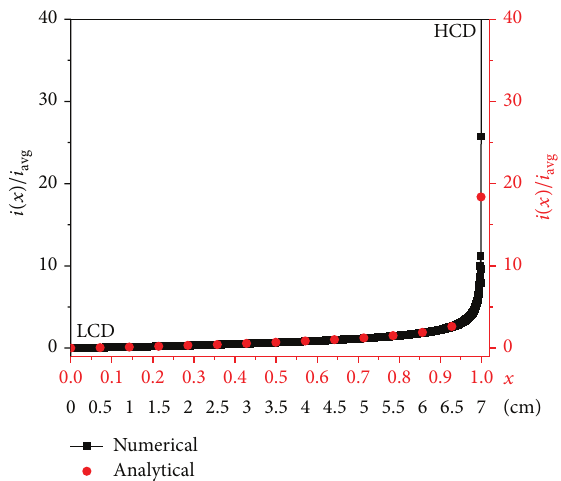
Figure 8: Comparison of analytical and numerical solutions for primary current distribution for modified Hull cell.